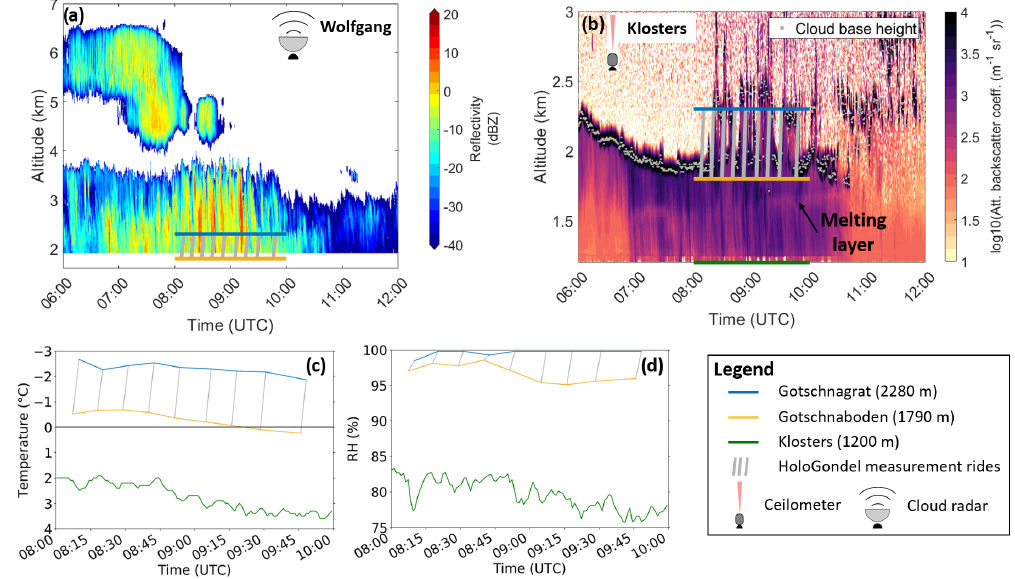
Figure 3. Observations of the reflectivity measured by the cloud radar installed in Wolfgang are shown in (a) . The ceilometer data in (b) show the estimated cloud base with gray dots above Klosters. A dark band underneath the cloud base indicates the melting layer. Temperature and relative-humidity measurements at the highest (closest to Gotschnagrat) and lowest point (closest to Gotschnaboden) of the gondola measurements and Klosters during the time HoloGondel was measuring are shown in (c) and (d) , respectively.